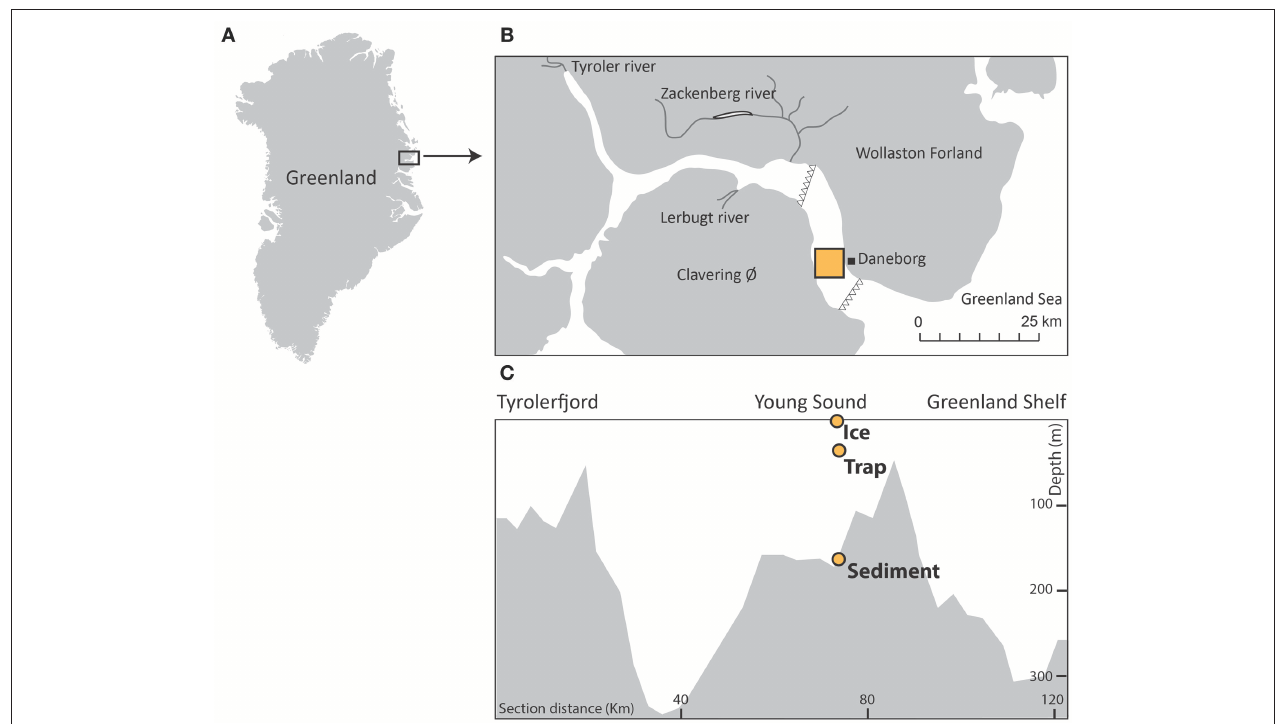
FIGURE 1 | (A) Location of the study area, in Northeast Greenland, (B) enlarged map of the Young-Sound-Tyrolerfjord system showing the main rivers and sampling site, and (C) bathymetry (m) from the inner to the outer fjord region and position of the sampling stations. The white triangles show the approximate position of the July sea-ice edge (modified from Ribeiro et al.,